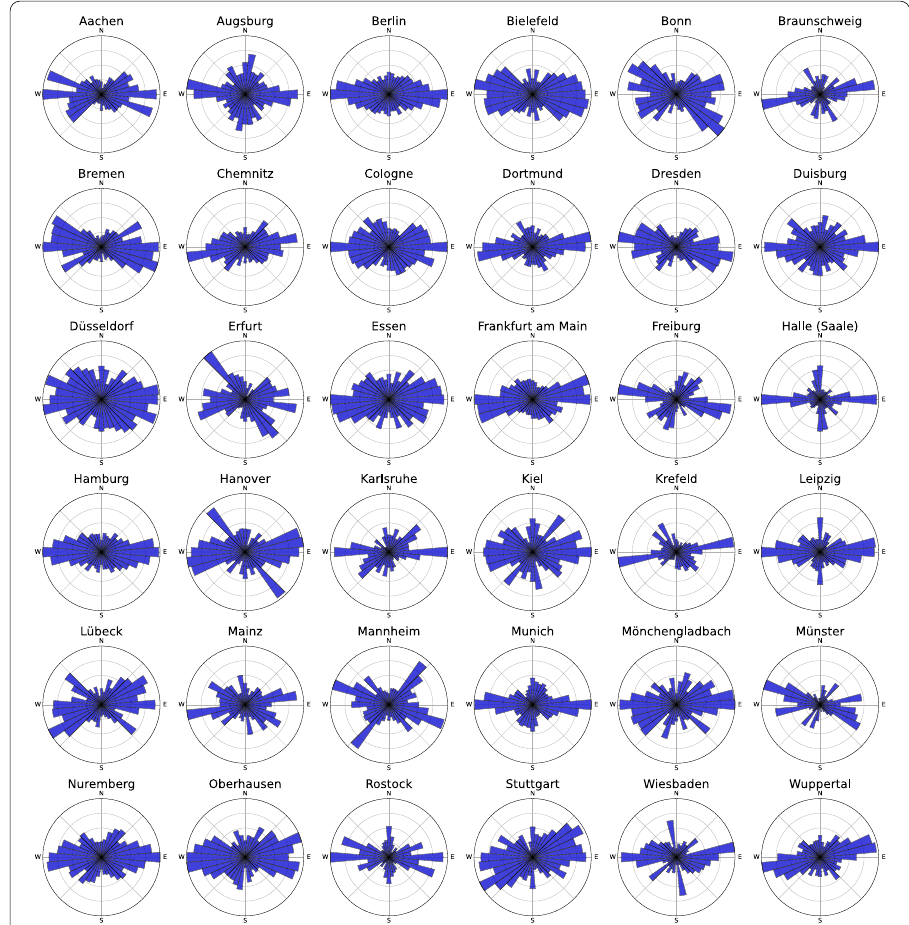
Fig. 3 Public transport network orientations of the 36 largest German cities with valid GTFS data as described in the "Data"